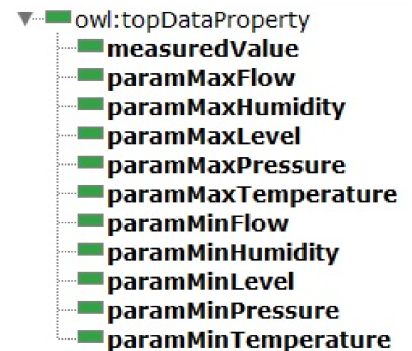
Figure 8. Data properties for parameter types.